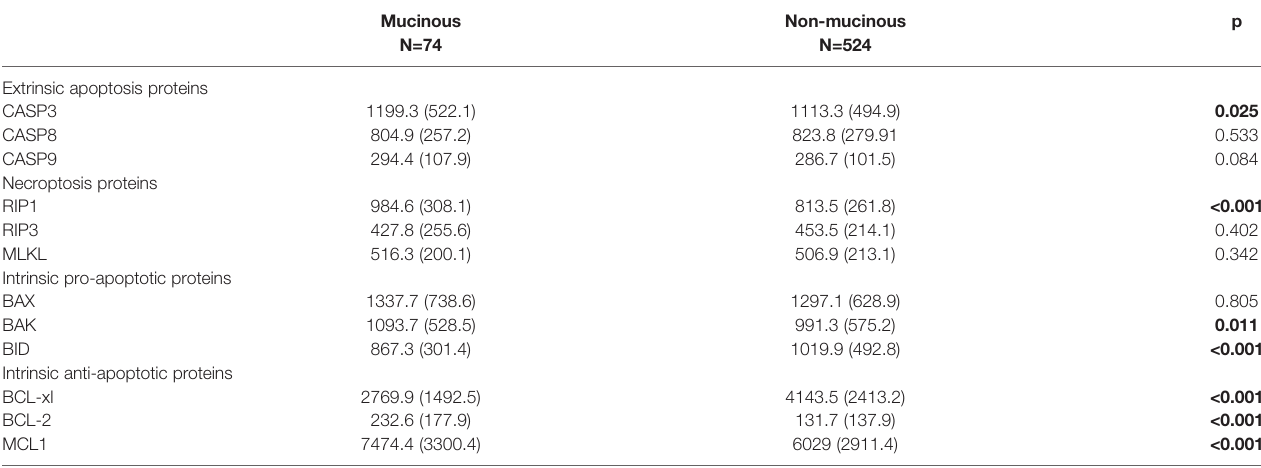
TABLE 1 | Gene expression of mucinous and non-mucinous colorectal cancer in TCGA